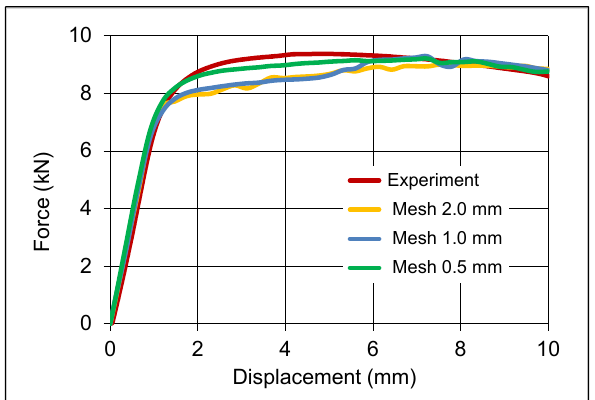
Figure 6. Force–deflection diagram for the 1st bending test at different mesh sizes (MJC model).